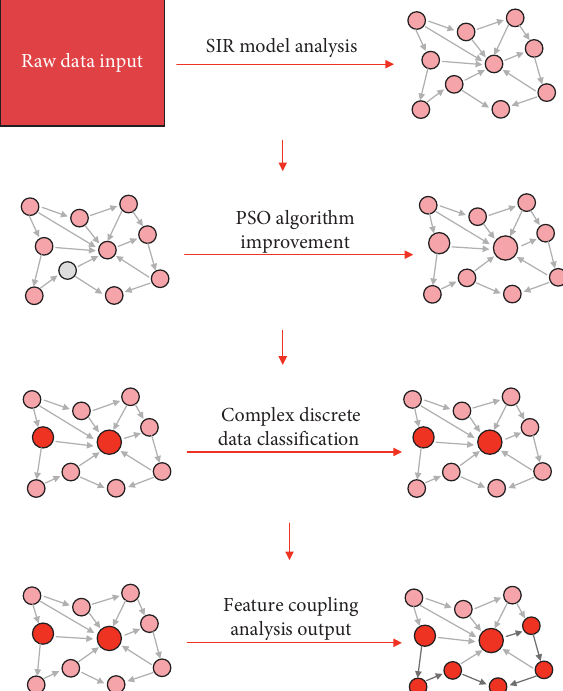
Figure 1: Computational flowchart of complex discrete